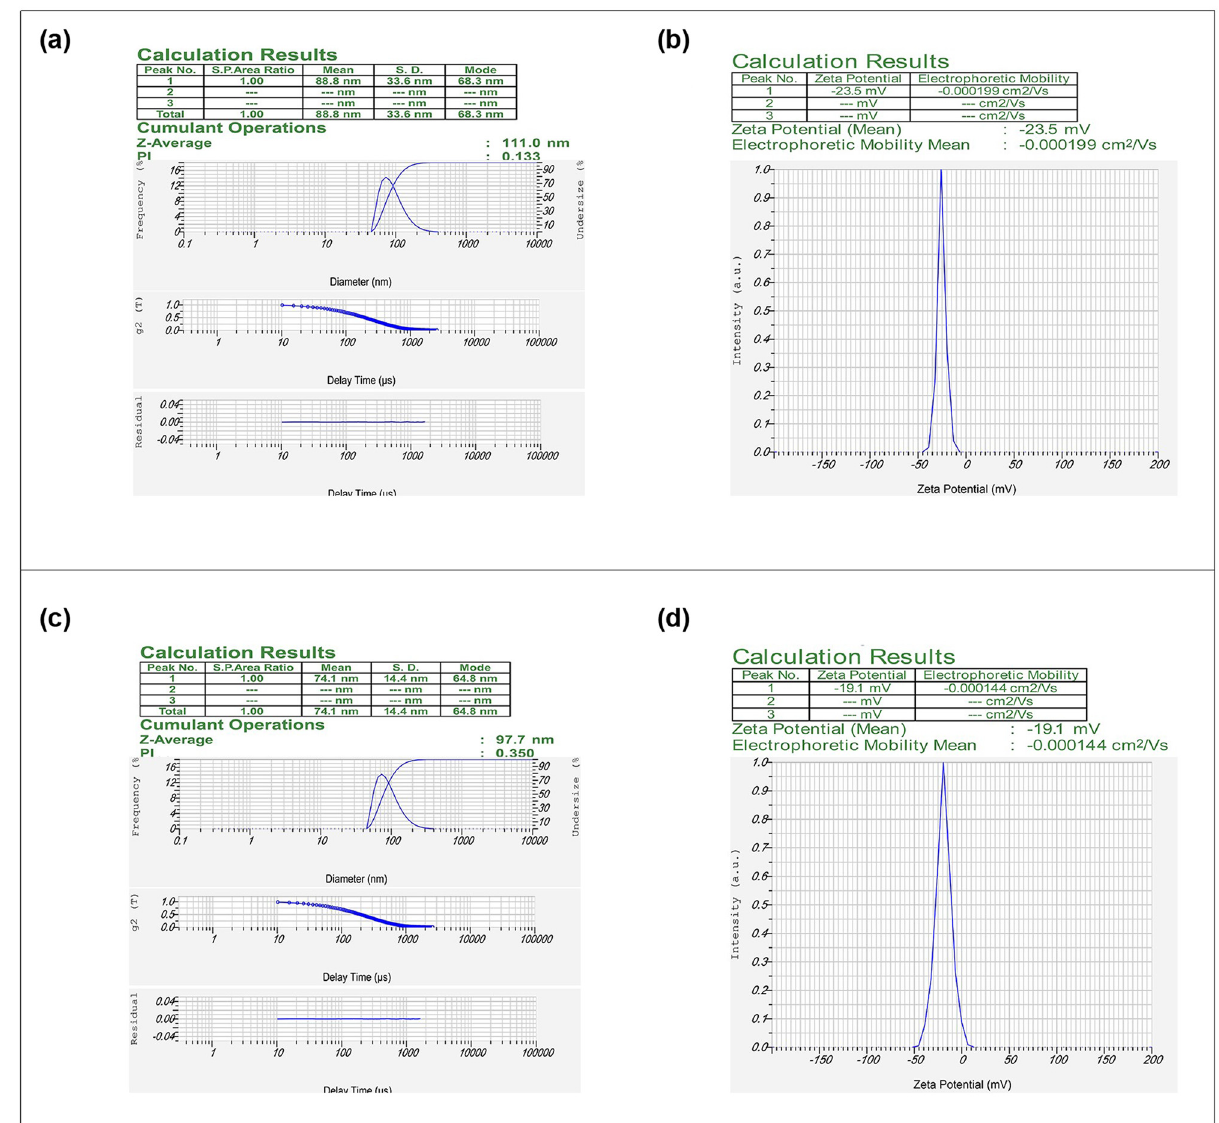
Figure 2: Investigating the optimal formulation of synthesized niosomes after loading extract in terms of size and zeta potential. ( a ) Size of Nio - GGE. ( b ) Zeta potential of Nio - GGE. ( c ) Size of Nio - HHE. ( d ) Zeta potential of Nio - HHE. Data obtained from DLS